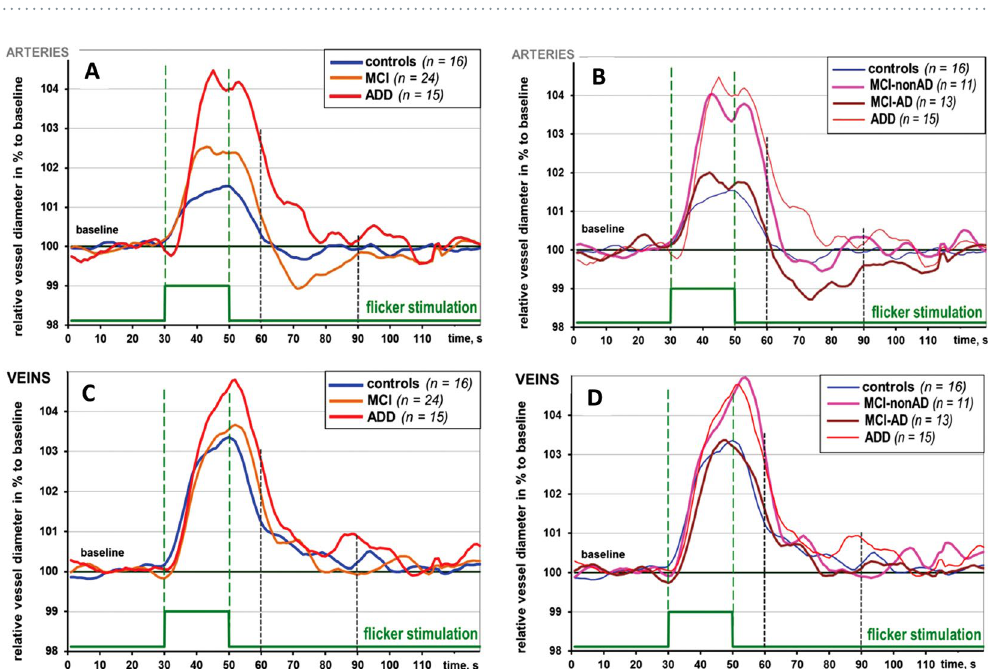
Figure 3. Arterial and venous reaction in the groups: relative vessel diameter changes in % to the baseline during flicker stimulation cycle (monochromatic, 12.5 Hz, 20 s). ( A , C ) MCI group uniform: ( B , D ) MCI group divided in two subgroups: MCI-nonAD and MCI-AD. Grey vertical stripes show the time interval 10–40 s after flicker cessation where arterial constriction and an emphasized decrease of venous diameter are expected in healthy